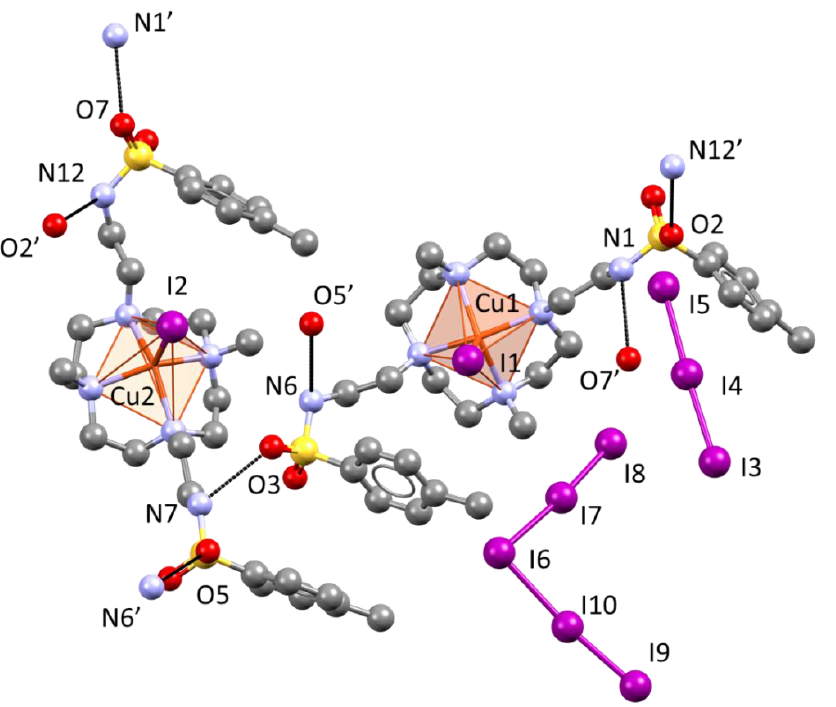
Figure 6. Asymmetric unit of the crystal structure of [Cu(L)I] 2 I 3 I 5 . Symmetry-related atoms completing dangling H-bonds (black) are also shown, hinting at the resulting network of H-bonded sulfonamides.